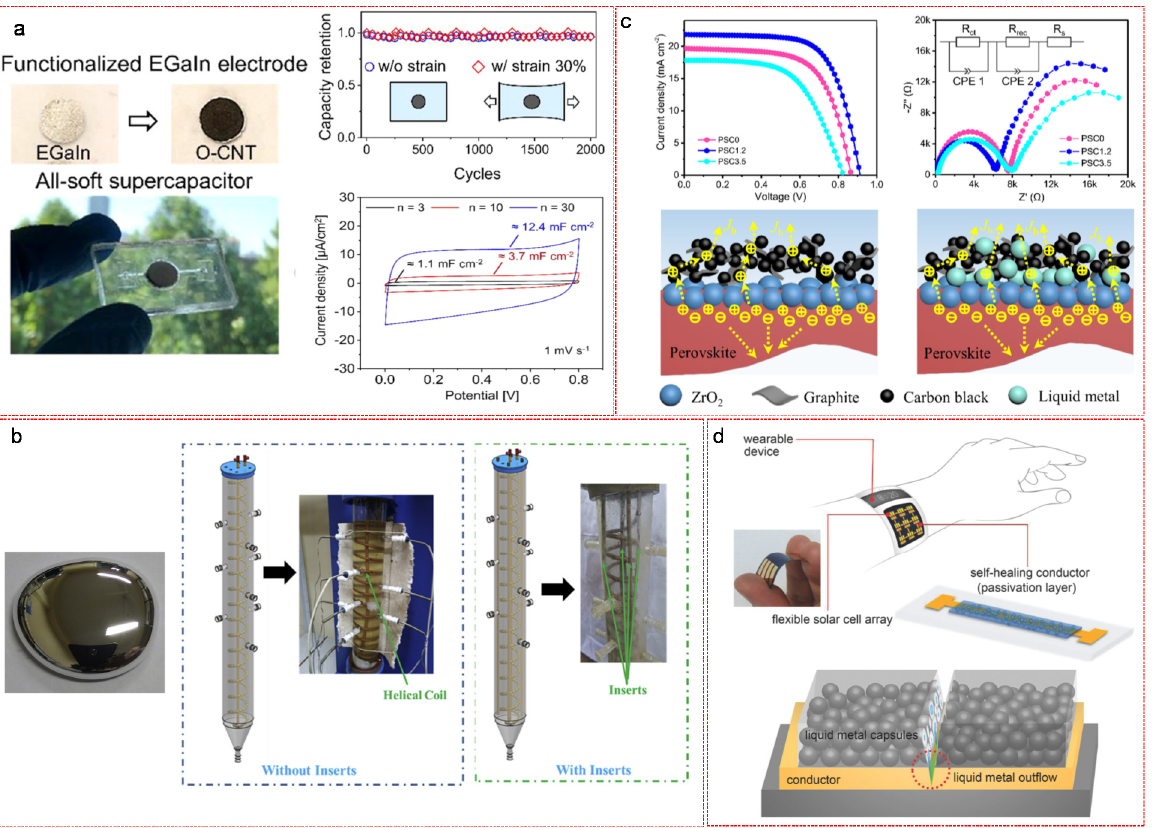
Figure 9. LM based materials for energy storage and harvesting devices. ( a ) All-soft LM supercapacitor showing an ultra-high capacitance and stable cycling performance under 30% strain. Reproduced with permission. [111] Copyright 2020, American Chemical Society. ( b ) LM inserted novel heat transfer enhanced solar thermal energy storage system. Reproduced with permission. [112] Copyright 2020, Elsevier B.V. ( c ) The mechanism of the interface engineering with LM for enhanced hole extraction and transport, and the corresponding current-voltage, electrochemical impedance curves. Reproduced with permission. [113] Copyright 2018, American Chemical Society. ( d ) Self-healing LM conductor for flexible wearable solar cell to restore the electrical conduction when damages happen. Reproduced with permission. [115] Copyright 2018,